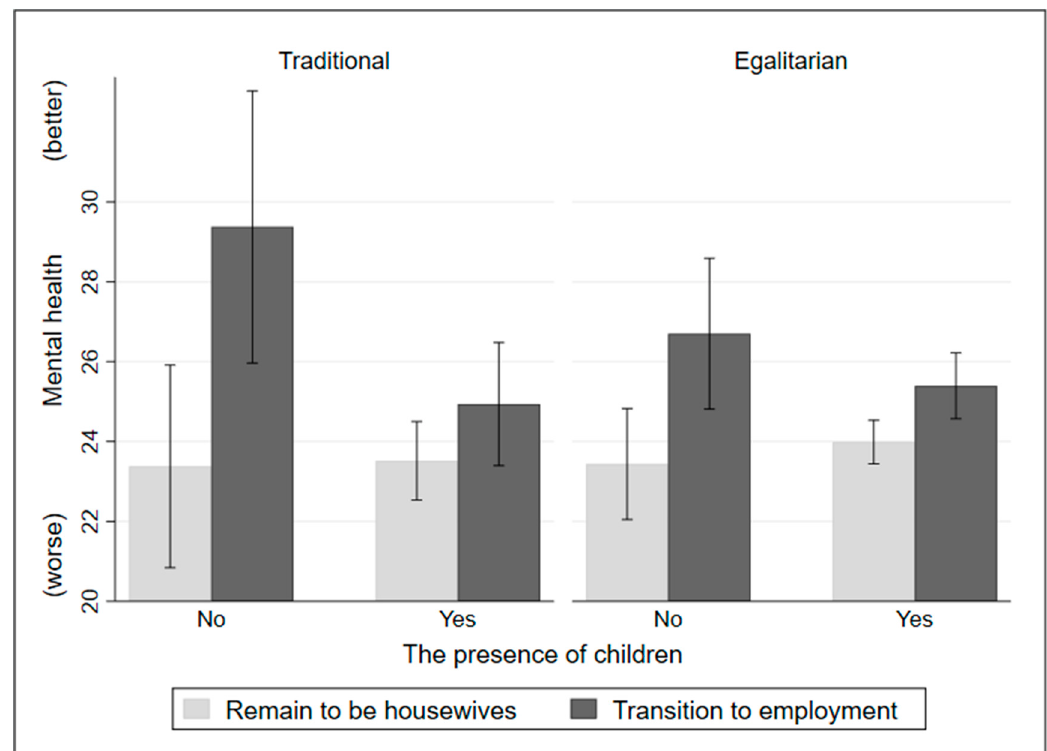
Figure 2. The moderation effects of the presence of children in the impacts of job status transition (total sample).